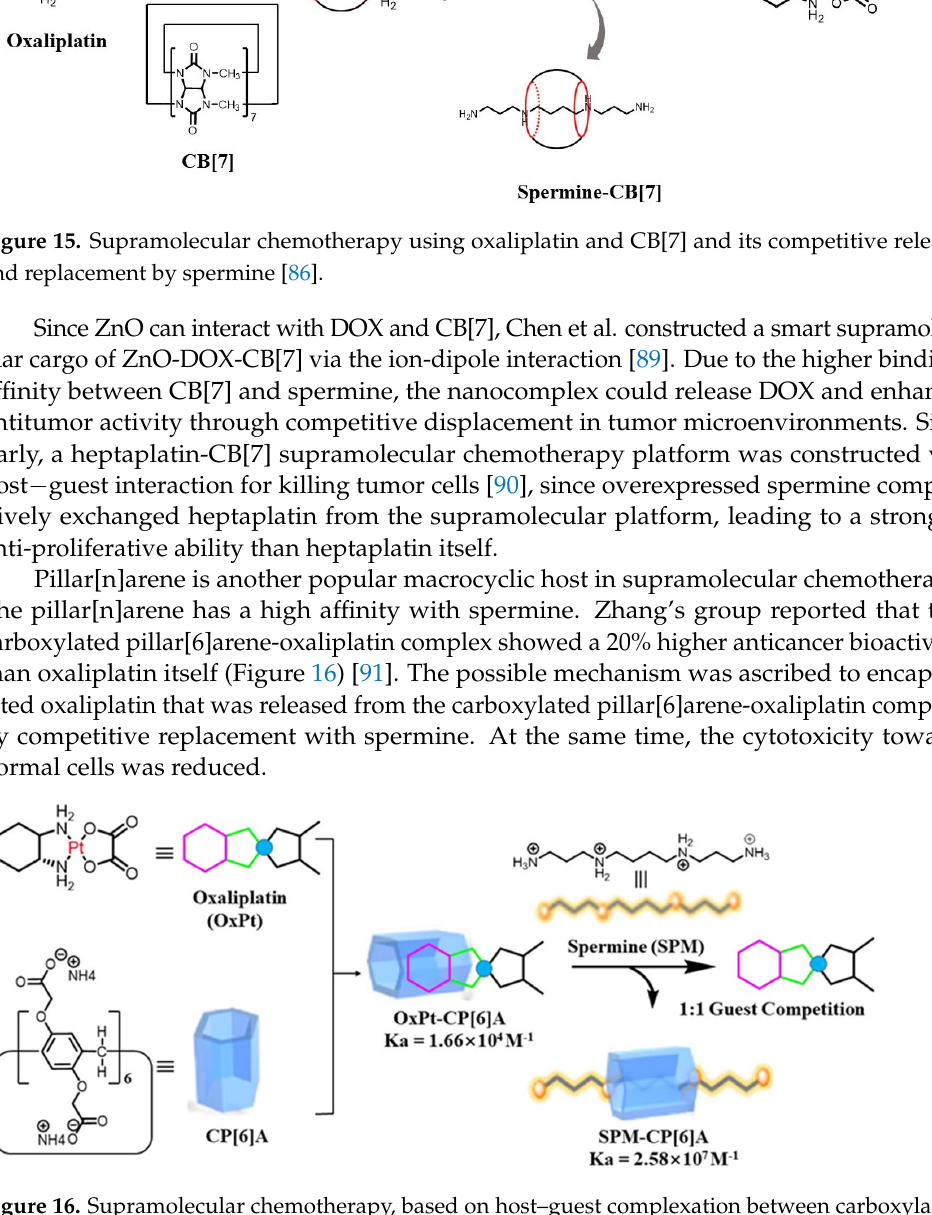
17 Figure 17. The combination of photodynamic therapy with a putative depletion of polyamines on cancer treatment with compound 17 [95].